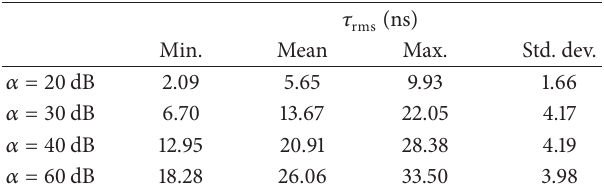
Table 4: Statistical values for the delay spread in terms of the threshold level ( 𝛼 ).